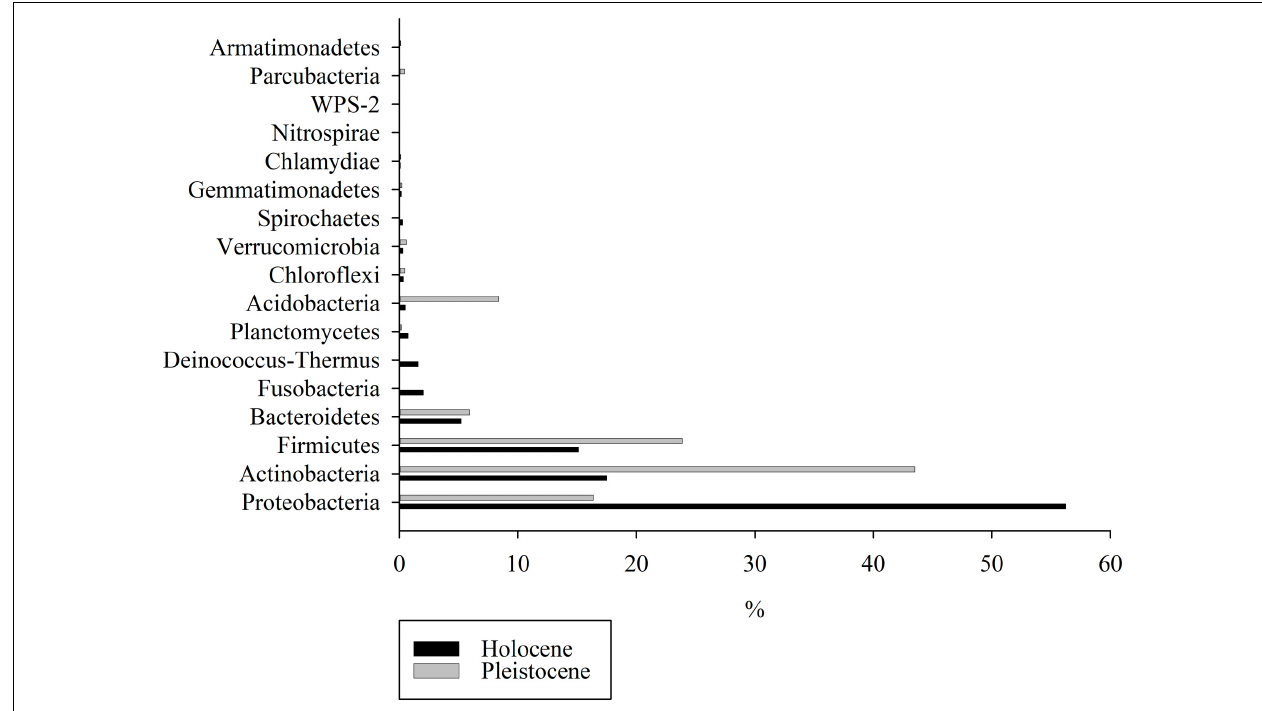
FIGURE 3 | Relative abundance analyses of the OTUs detected in Holocene-aged and Pleistocene-aged permafrost samples at the phylum